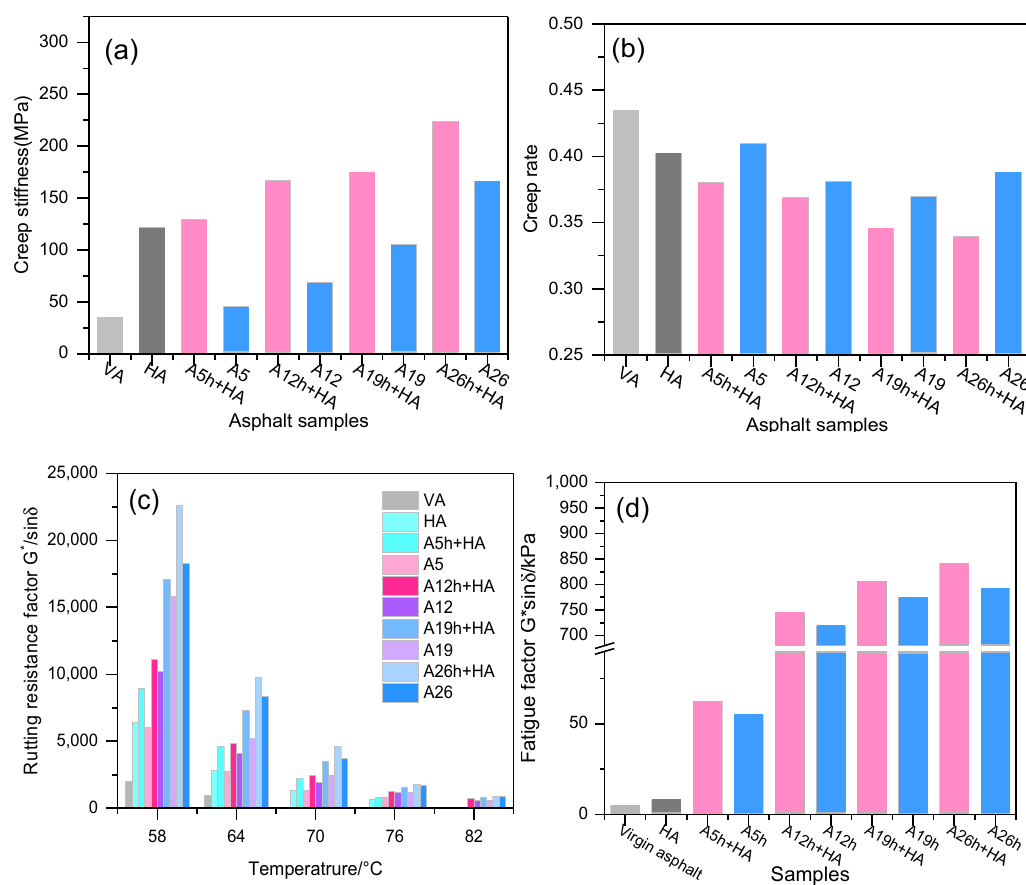
Figure 9. Rheological properties of recycled asphalt binder: ( a ) creep stiffness; ( b ) creep rate; ( c ) rutting factor; ( d ) fatigue